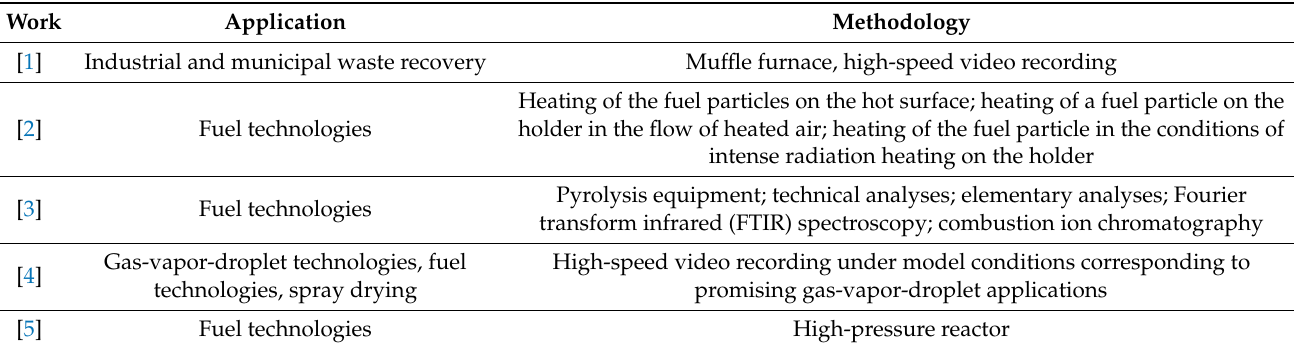
Table 1. Practical applications and methods of research in the Special Issue